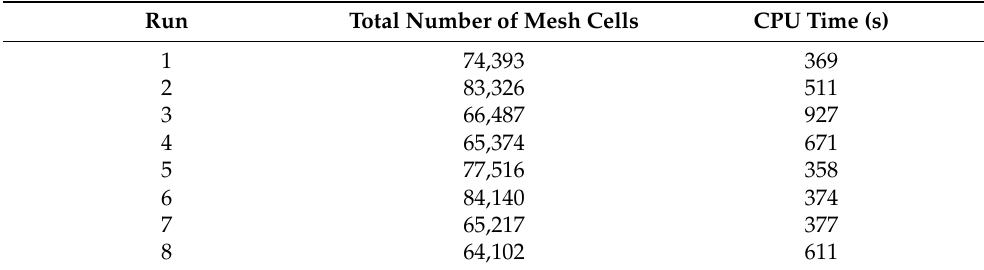
Figure 11. Representation of mesh created after definition of global and local meshes for the geometry with lateral air inlet and outlet. Table 8. Representation of best combinations of global and local meshes for each run, number of mesh cells, and time of central processing unit (CPU) generated by these mesh combinations for the geometry with upper air inlet and